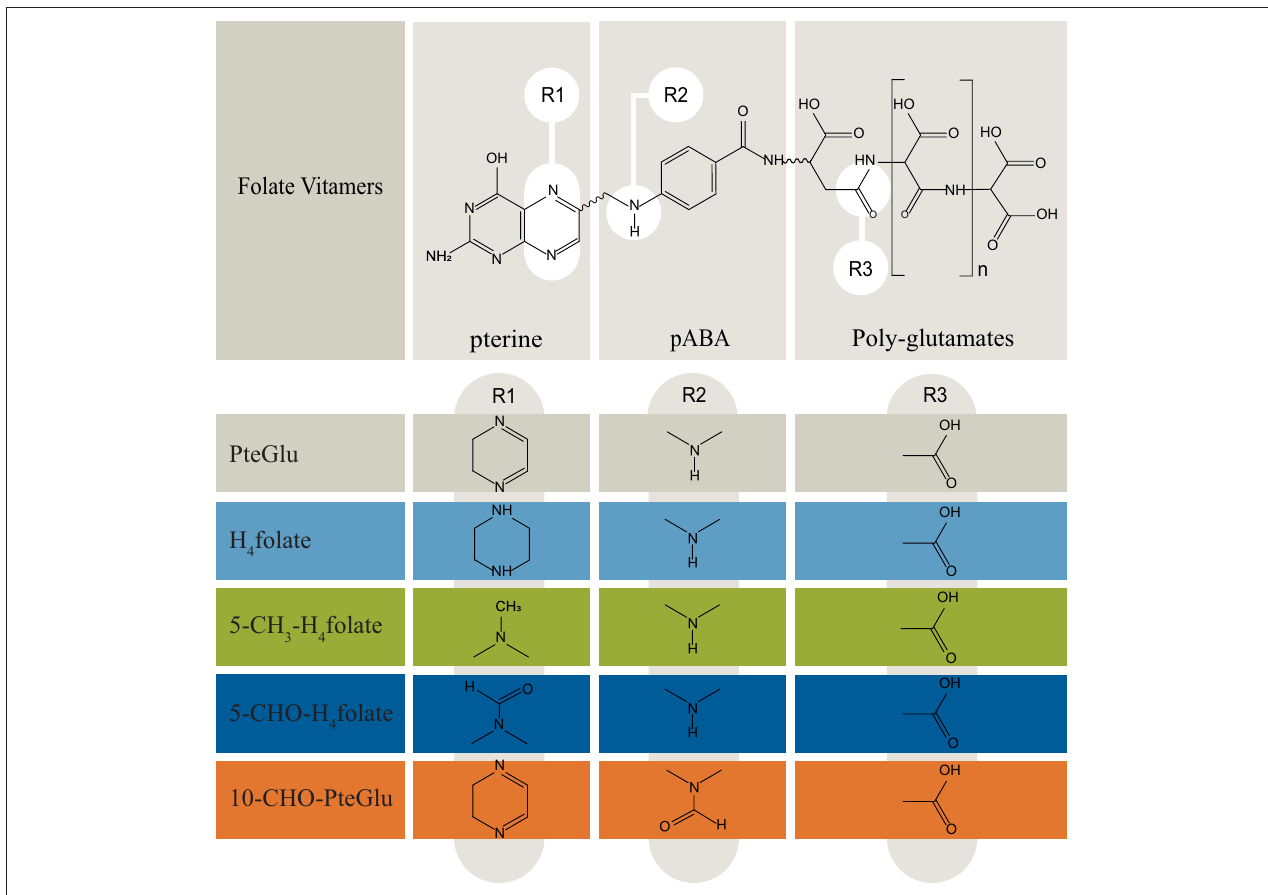
FIGURE 1 | Overview of folate vitamers chemistry (Delchier et al., 2016). Folates are mostly present in the polyglutamated form, which need to be cleaved during sample preparation for quantitative LC-HRMS measurements. pABA, para-aminobenzoic acid. n , number of glutamates: